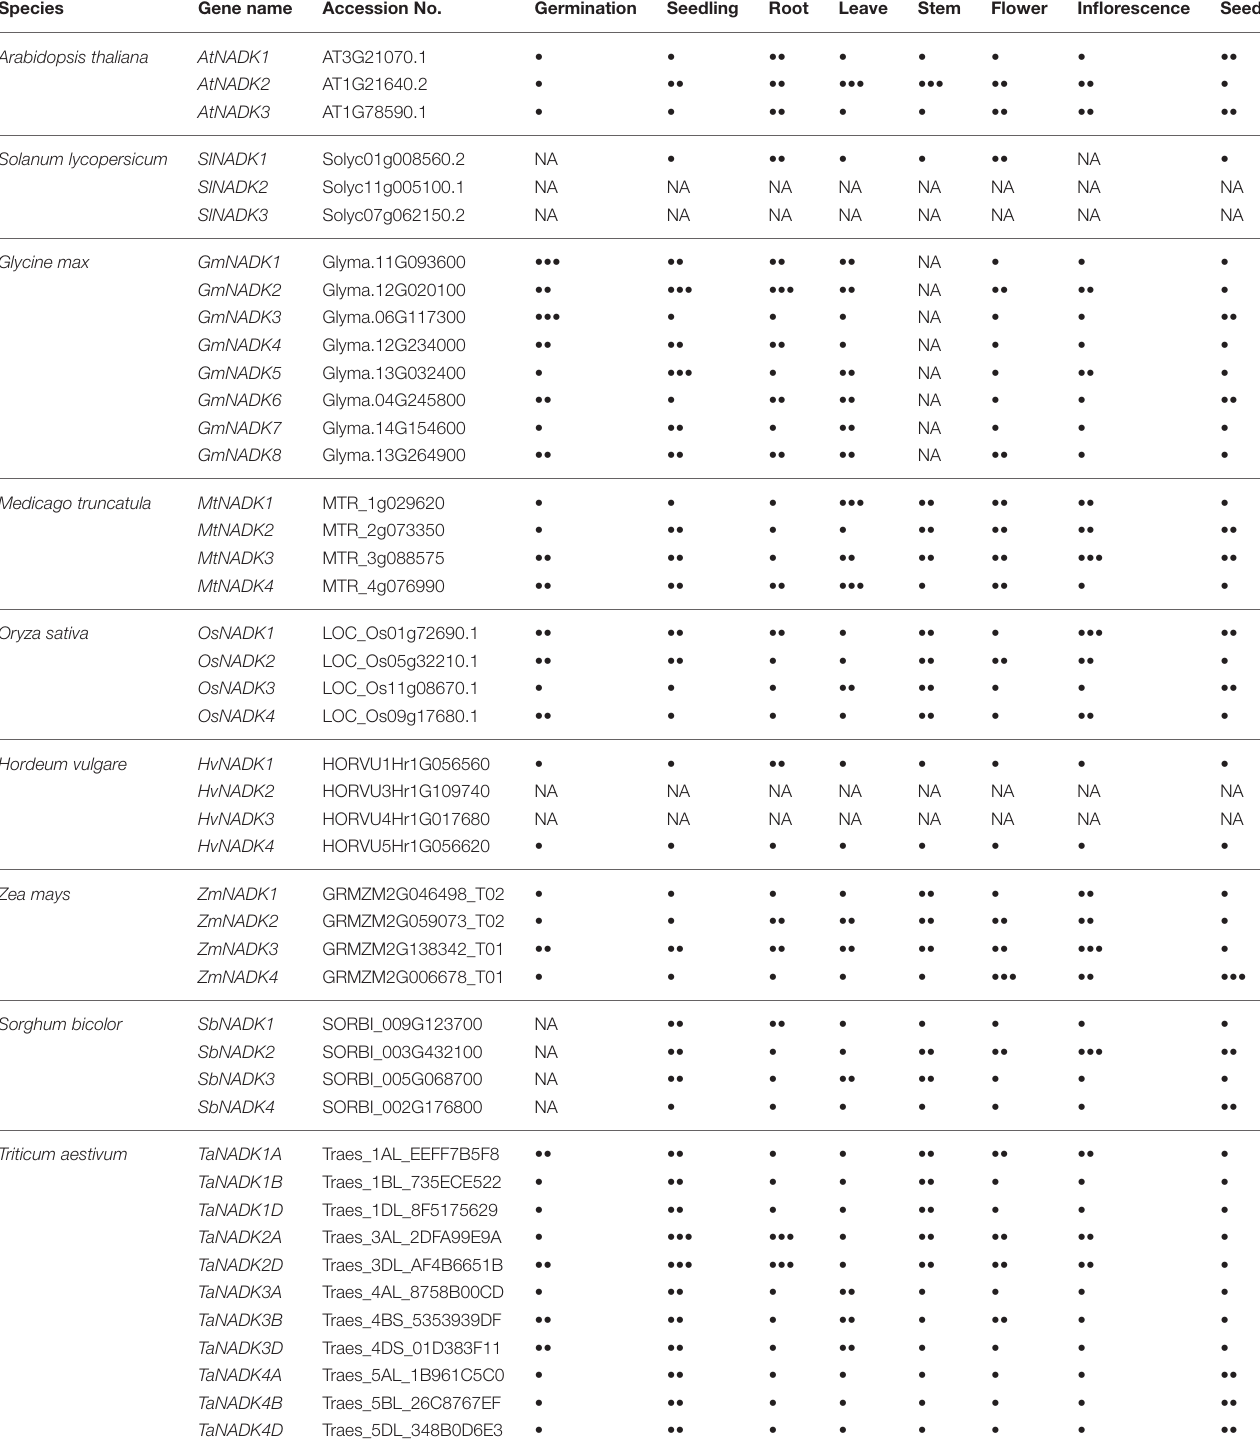
TABLE 2 | Developmental and anatomical expression patterns of NADK family genes in plants.